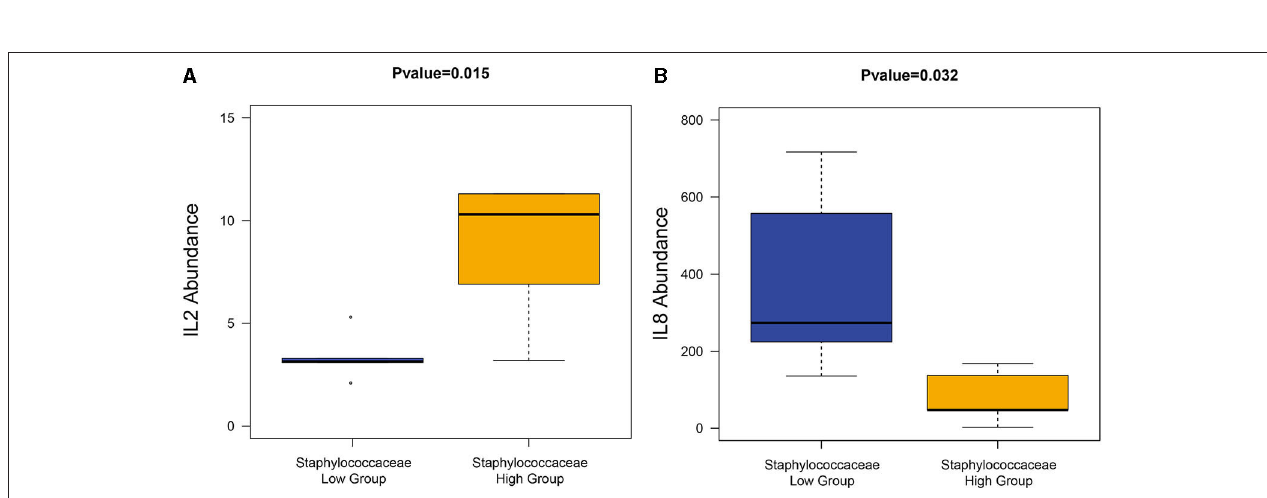
FIGURE 7 | The correlation between Staphylococcaceae and cytokines. The high Staphylococcaceae abundance group sample had a significantly high abundance of IL2 (A) and IL8 (B) .